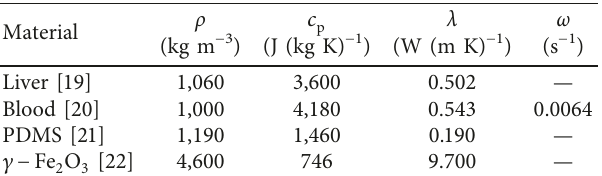
Table 1: Thermal properties of the materials used in the FEM